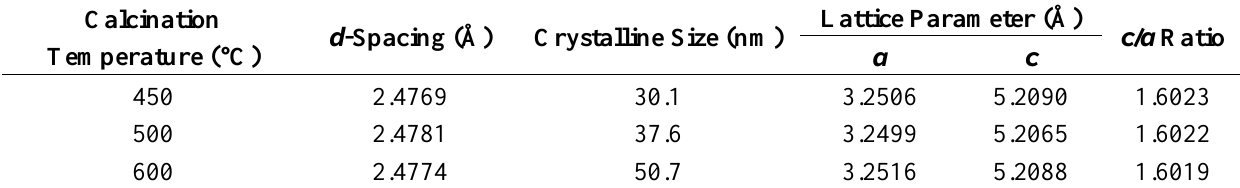
Figure 3. X-ray diffraction spectra of as-prepared sample and ZnO nanoparticles at different calcination temperatures. Table 1. Structural parameters of ZnO nanocrystals from XRD pattern for (101) plane.